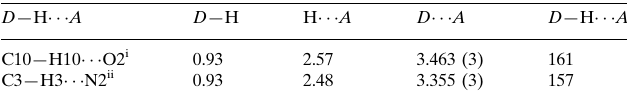
Hydrogen-bond geometry (A˚ , (cid:1)